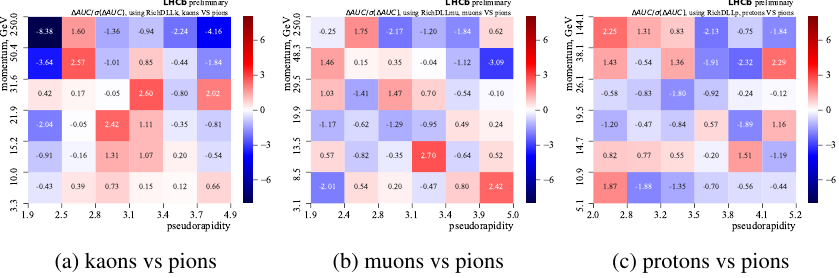
Figure 6: Separation power comparison. Di ff erences between ROC AUC for discriminat- ing pions from kaons, muons and protons classifiedd with the RichDLLk , RichDLLmu and RichDLLp variables, respectively for real calibration samples and using RICH GAN gener- ated values, divided by the ROC AUC uncertainties, in bins of momentum and pseudorapidity.